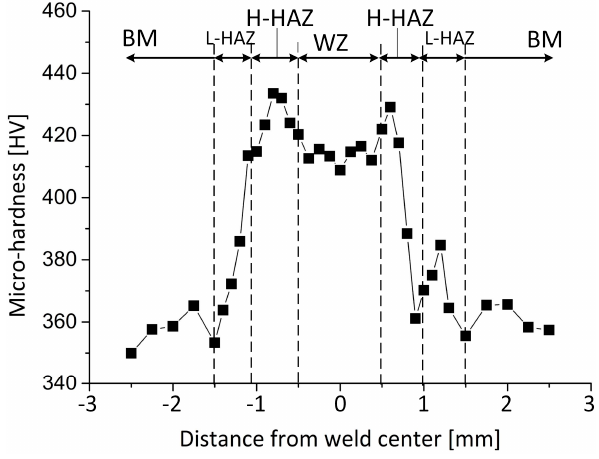
Figure 6. Microhardness profile along the cross section of the laser welded joint.